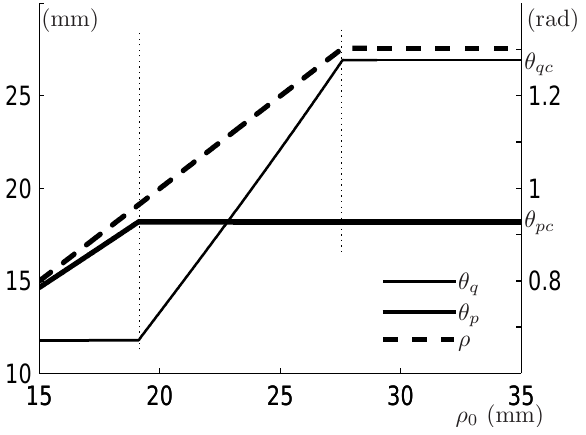
( θ p ,θ q ) plane. Results: Figure 4 shows the configuration tual length of the actuator for ρ 0 between 15 mm and 35